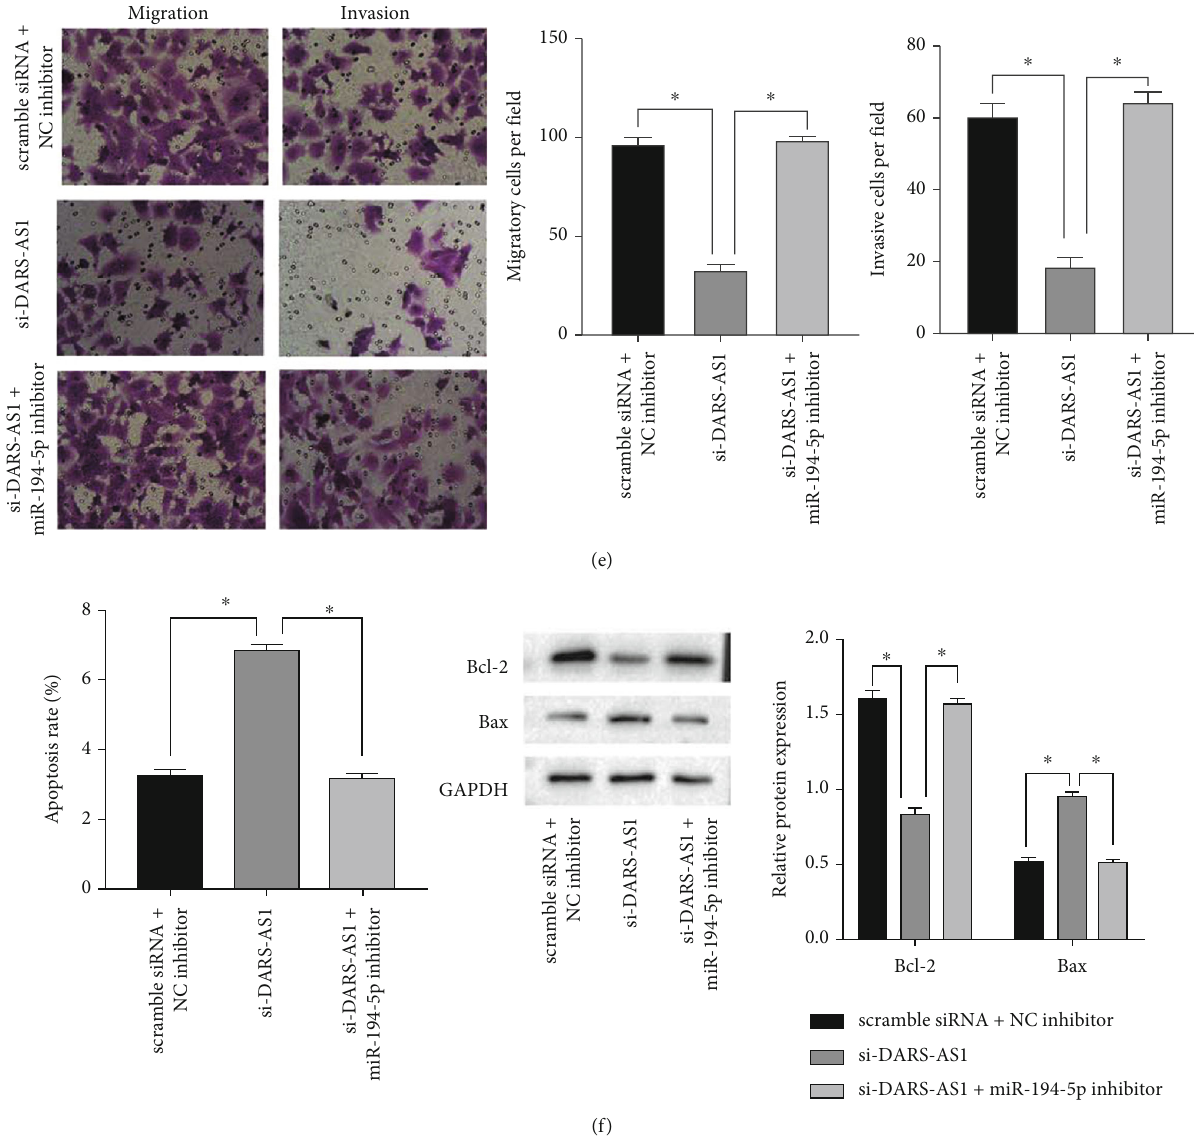
Figure 3: lncRNA DARS-AS1 depletes miR-194-5p and regulates OC cell behaviors. (a) The luciferase activity detection. (b) qRT-PCR detection of miR-194-5p expression in OC cell model and normal cell lines. (c) qRT-PCR detection of miR-194-5p expression in A2780 cells following transfection with si-DARS-AS1 and/or miR-194-5p inhibitor. (d) CCK-8 assay detection of A2780 cell viability following transfection with si-DARS-AS1 and/or miR-194-5p inhibitor. (e) Representative migratory or invasive A2780 cells per fi eld and numbers of migratory or invasive cells following transfection with si-DARS-AS1 and/or miR-194-5p inhibitor. (f) Apoptosis rates of A2780 cells, western blots, and gray values of apoptosis-related proteins in A2780 cells following transfection with si-DARS-AS1 and/or miR-194-5p inhibitor. A symbol of ∗ represents p < 0 : 05